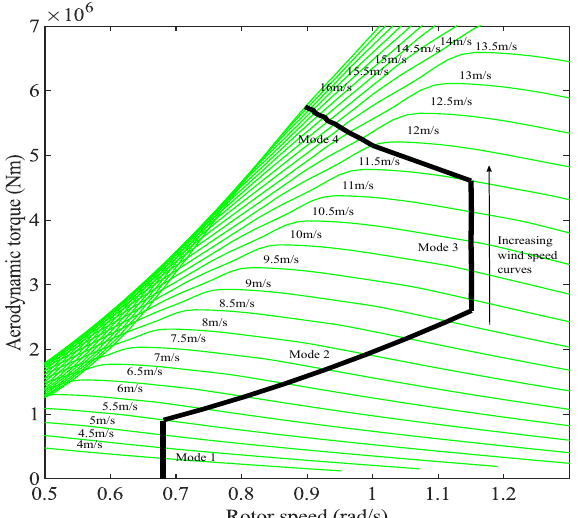
Figure 3. Control strategy in the speed-torque plane; the green curves represent wind speeds increasing from 4 to 24 m/s with an increment of 0.5